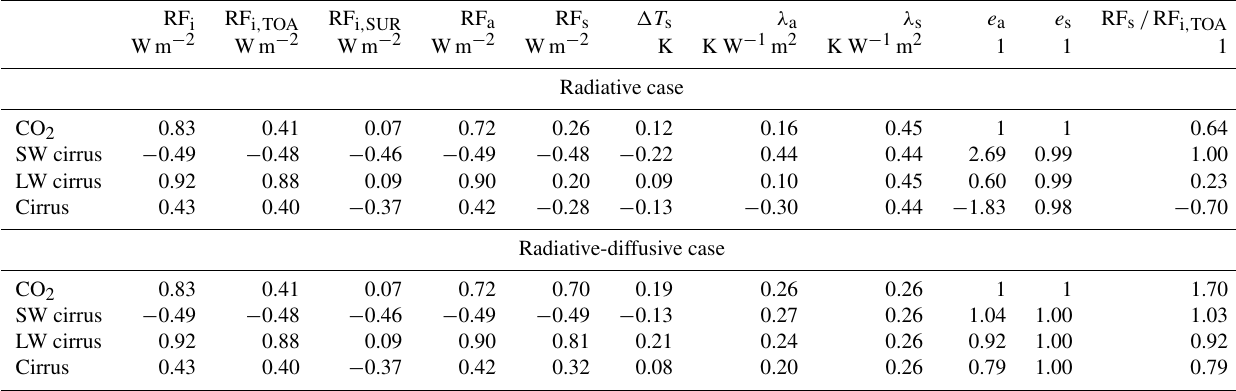
Table 1. Radiative Forcing (RF) ∗ , surface temperature change (cid:49)T s , sensitivity parameters λ and efficacies e relative to adjusted and effective RF a and RF s , for contrail cirrus and CO 2 for the given model. The first four rows are the radiative cases with zero turbulent fluxes, the last four rows apply for the radiative-diffusive cases. The instantaneous and adjusted RF values are the same for both cases. Negative λ and e values are considered ill-conditioned because highly sensitive to small changes in forcing and mixing